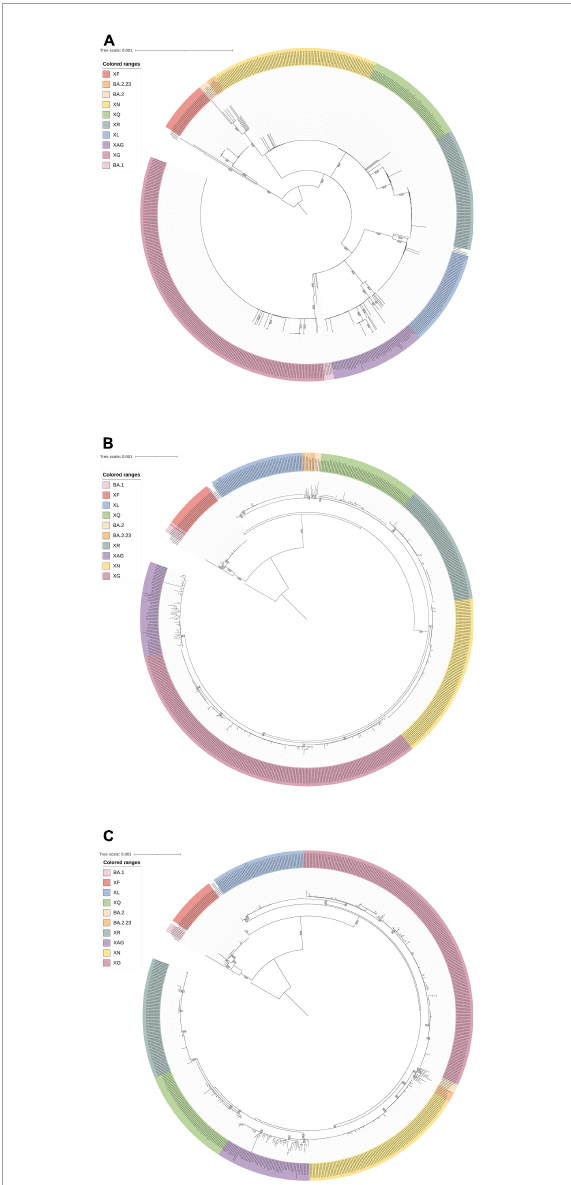
FIGURE3 Phylogenetic analysis. The multiple alignment was used in IQ-Tree for estimating the Maximum-Likelihood phylogeny. Bootstrap analyzes were made using SH-like approximate likelihood ratio test with 1,000 replicates. (A) Phylogenetic tree reconstructed with the first fragment of the beginning of the genome up to 6,512 nt position (considered the probable recombination breakpoint), with characteristics like Omicron BA.1 (Model: TIM + F + I). (B) Phylogenetic tree reconstructed with the second fragment after the 6,512 nt position, the genomic section likely derived from Omicron BA.2/BA.2.23 (Model: TIM + F + R3). (C) Phylogenetic tree reconstructed with the complete genome of XAG genome, other available recombinant lineages and parental BA.1 and BA.2 lineages (Model: TIM + F + R3). A dataset with representative sequences of the following lineages was used: Omicron BA.1, BA.2, BA.2.23, XF (Delta/Omicron BA.1), XL (Omicron BA.1/BA.2), XG (Omicron BA.1/BA.2), XN (Omicron BA.1/BA.2), XQ (Omicron BA.1/BA.2), XR (Omicron BA.1/BA.2), and XAG (Omicron